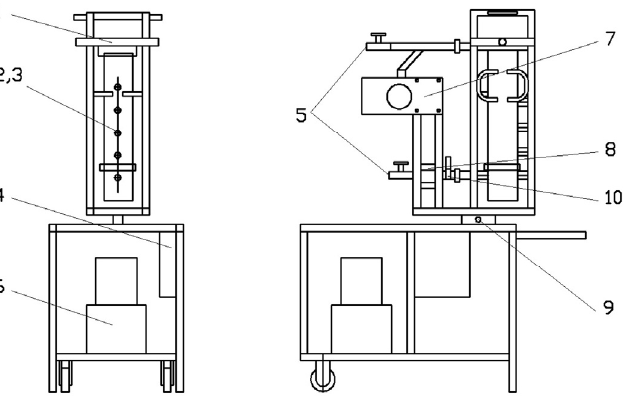
Figure 4. Laboratory test device structure (1—gas generator; 2,3—temperature probes; 4—electric panel; 5— pneumatic throttles; 6—compressor; 7,8—air flow meters; 9—electronic scale; 10—pressure transducer. The same components—in their physical form—are shown in Figure 5b below).